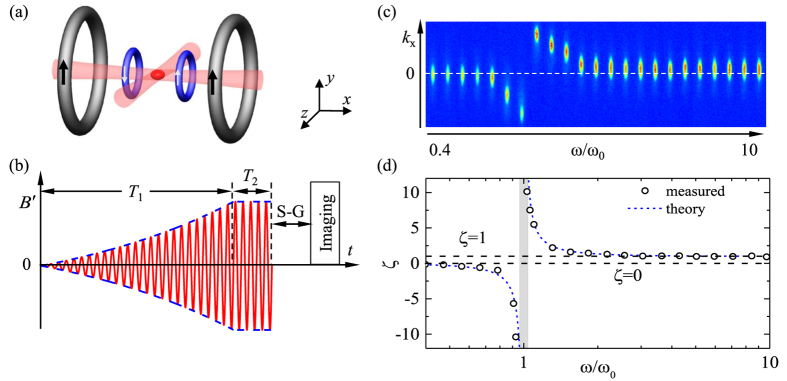
Harmonic-trap-resonance enhanced SOC. (a) Schematic illustration of the experimental setup, consisting of the bias (gray) and gradient (blue) magnetic coils. The condensate (red football shape) is produced at the center of a crossed optical dipole trap formed from laser beams in pink. Its location coincides with the center of the gradient coil configuration. (b) Time sequence of our experiments. The modulation amplitude (delimited by the blue dashed envelop) of the gradient magnetic field B′(t) (shown in red) is adiabatically ramped up to an effective value corresponding to kso = 1.25 μm−1 within T1 and held on for T2, followed by the Stern-Gerlach (S-G) separation before absorption imaging. To ensure adiabaticity during the ramp, T1 = 250 ms and T2 = 50 ms are chosen for the modulation frequency ω > (2π)100 Hz and T1 = 25τ and T2 = 5τ, with τ = 2π/ω being the modulation period, for ω < (2π)100 Hz. (c) Absorption images for the momentum-shifted atomic clouds in the |mF = −1〉 state at different values of ω. Darker red denotes higher optical density. The abscissa is not to scale. Each measured off-set atomic cloud corresponds to a data point shown in (d) in the same order of increasing modulation frequency from left to right. The dashed line denotes kx = 0 for without GMF or SOC. (d) The measured values of the scaled SOC strength ζ (black open circles) as a function of ω, which agree perfectly with Eq. (8) shown in the blue dotted curve. In the shaded band region surrounding the trap resonance, the driven atomic cloud fails to adiabatically reach the momentum-shifted equilibrium state after T2.